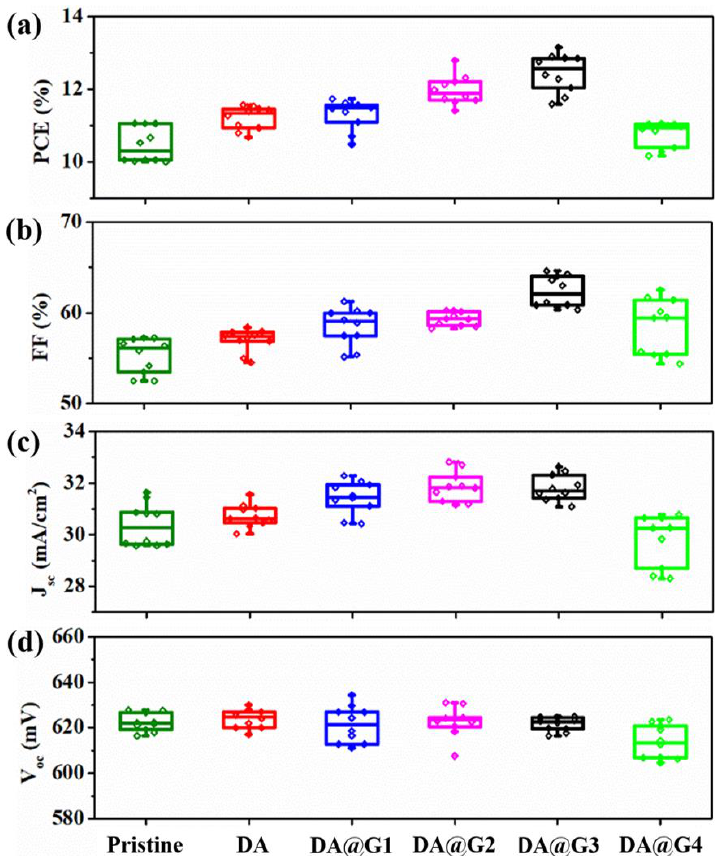
Figure 5. Performance parameters of prepared solar cells versus G concentration: ( a ) photovoltaic conversion efficiency (PCE), ( b ) fill factor (FF), ( c ) short-circuit current density (J sc ); ( d ) open-circuit voltage (V oc ).